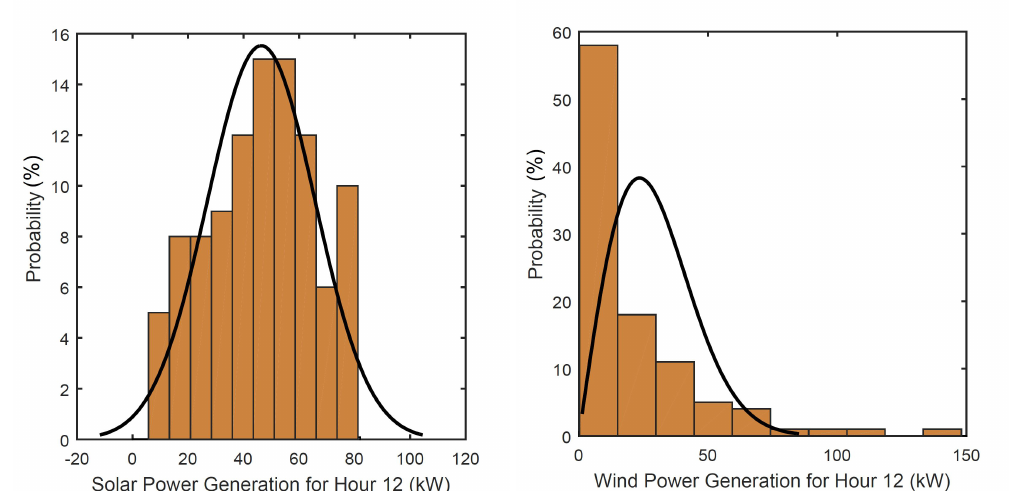
Figure 15. Probability of the power generation from solar PV ( left ) and wind ( right ) at the 12th hour on the 22 September case